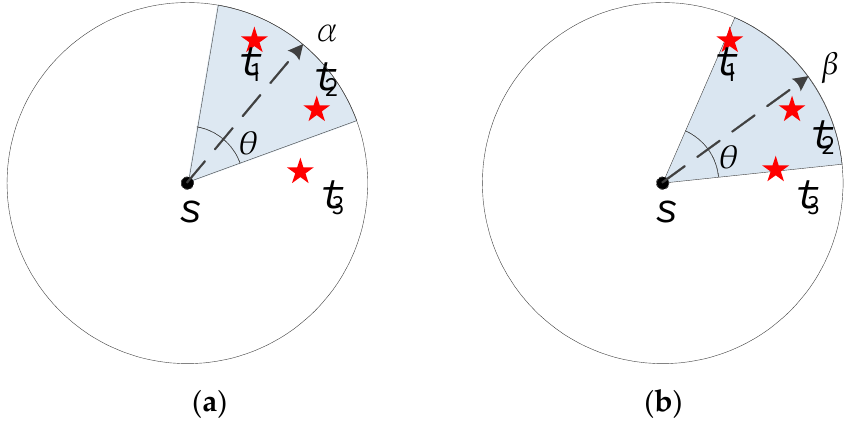
Figure 2. Rotation of a directional sensor s with three targets (indicated as red stars) located inside its sensing range. ( a ) Target 𝑡 3 is not covered by sensor s with sensing orientation α . ( b ) Target 𝑡 3 is covered by sensor s with sensing orientation β .